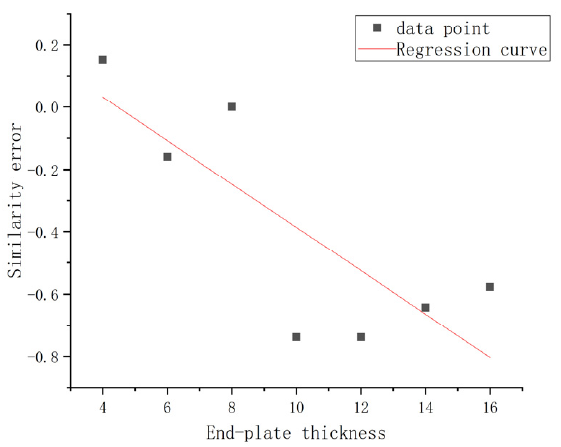
Figure 30. Data points and the regression curve at E p .